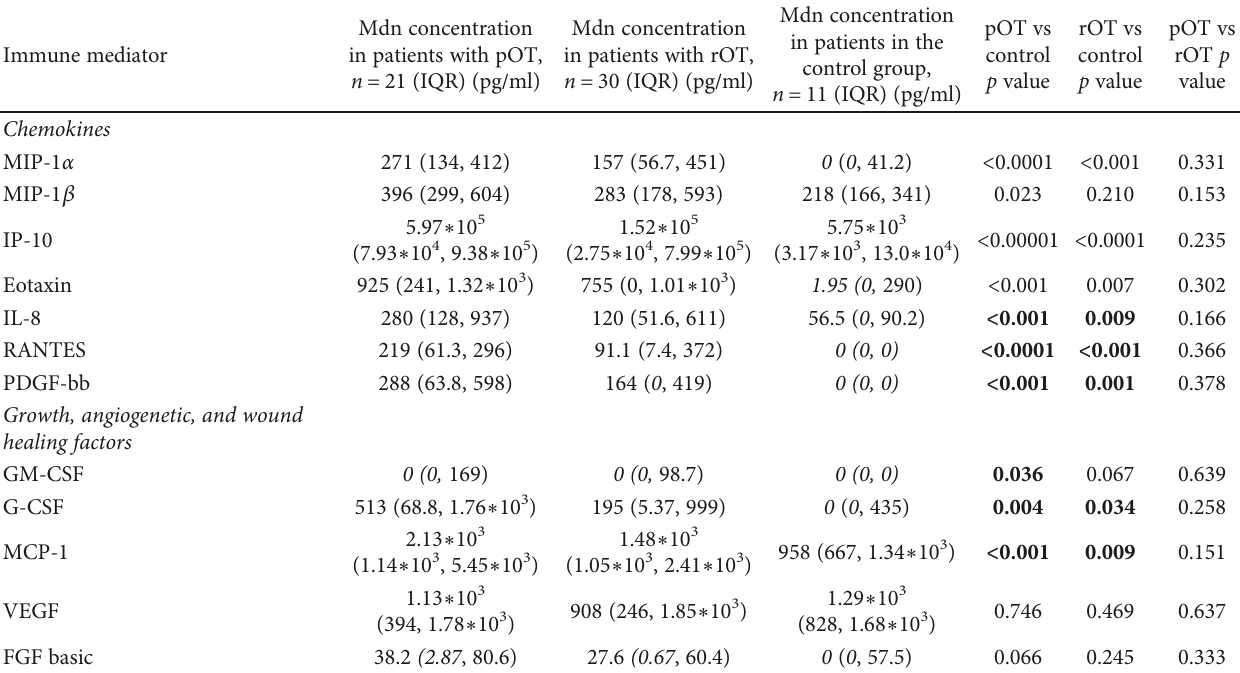
Table 3: Chemokines, growth factor, angiogenetic factor, and wound healing factor concentrations in aqueous humor of a control group and patients with pOT and rOT ( n = 62 ).